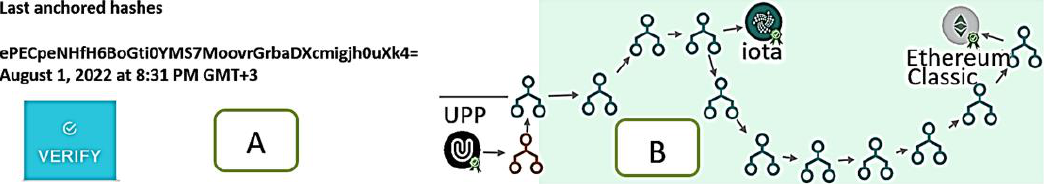
Figure 30. Data Verification and Blockchain Anchoring in Ethereum Classic, IOTA. ( A ) Verification button. ( B ) Blockchain procedure in graphic mode.